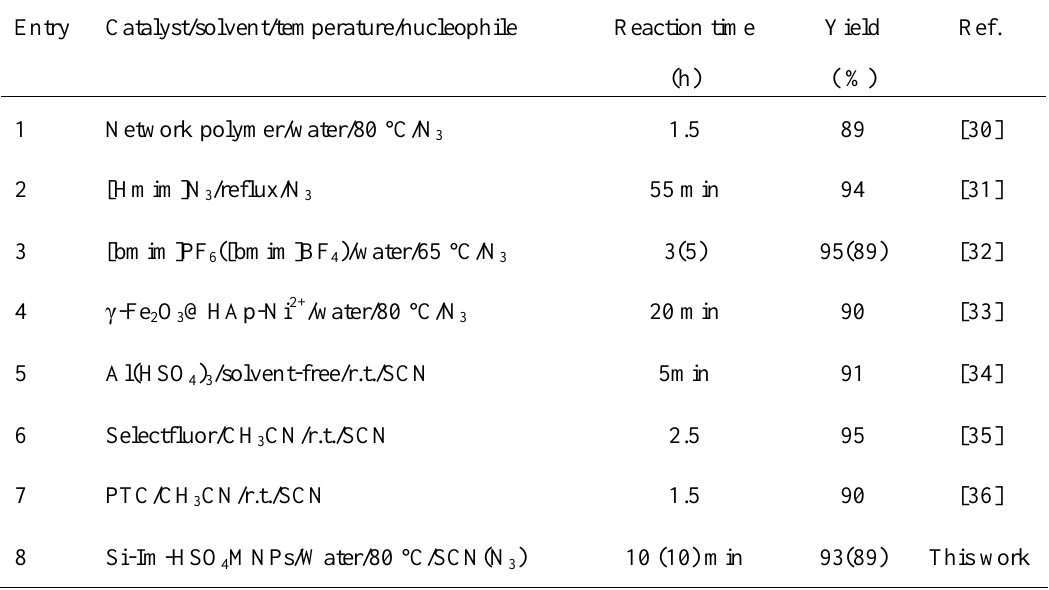
Table 3. Comparison of Catalytic Ability of Catalysts